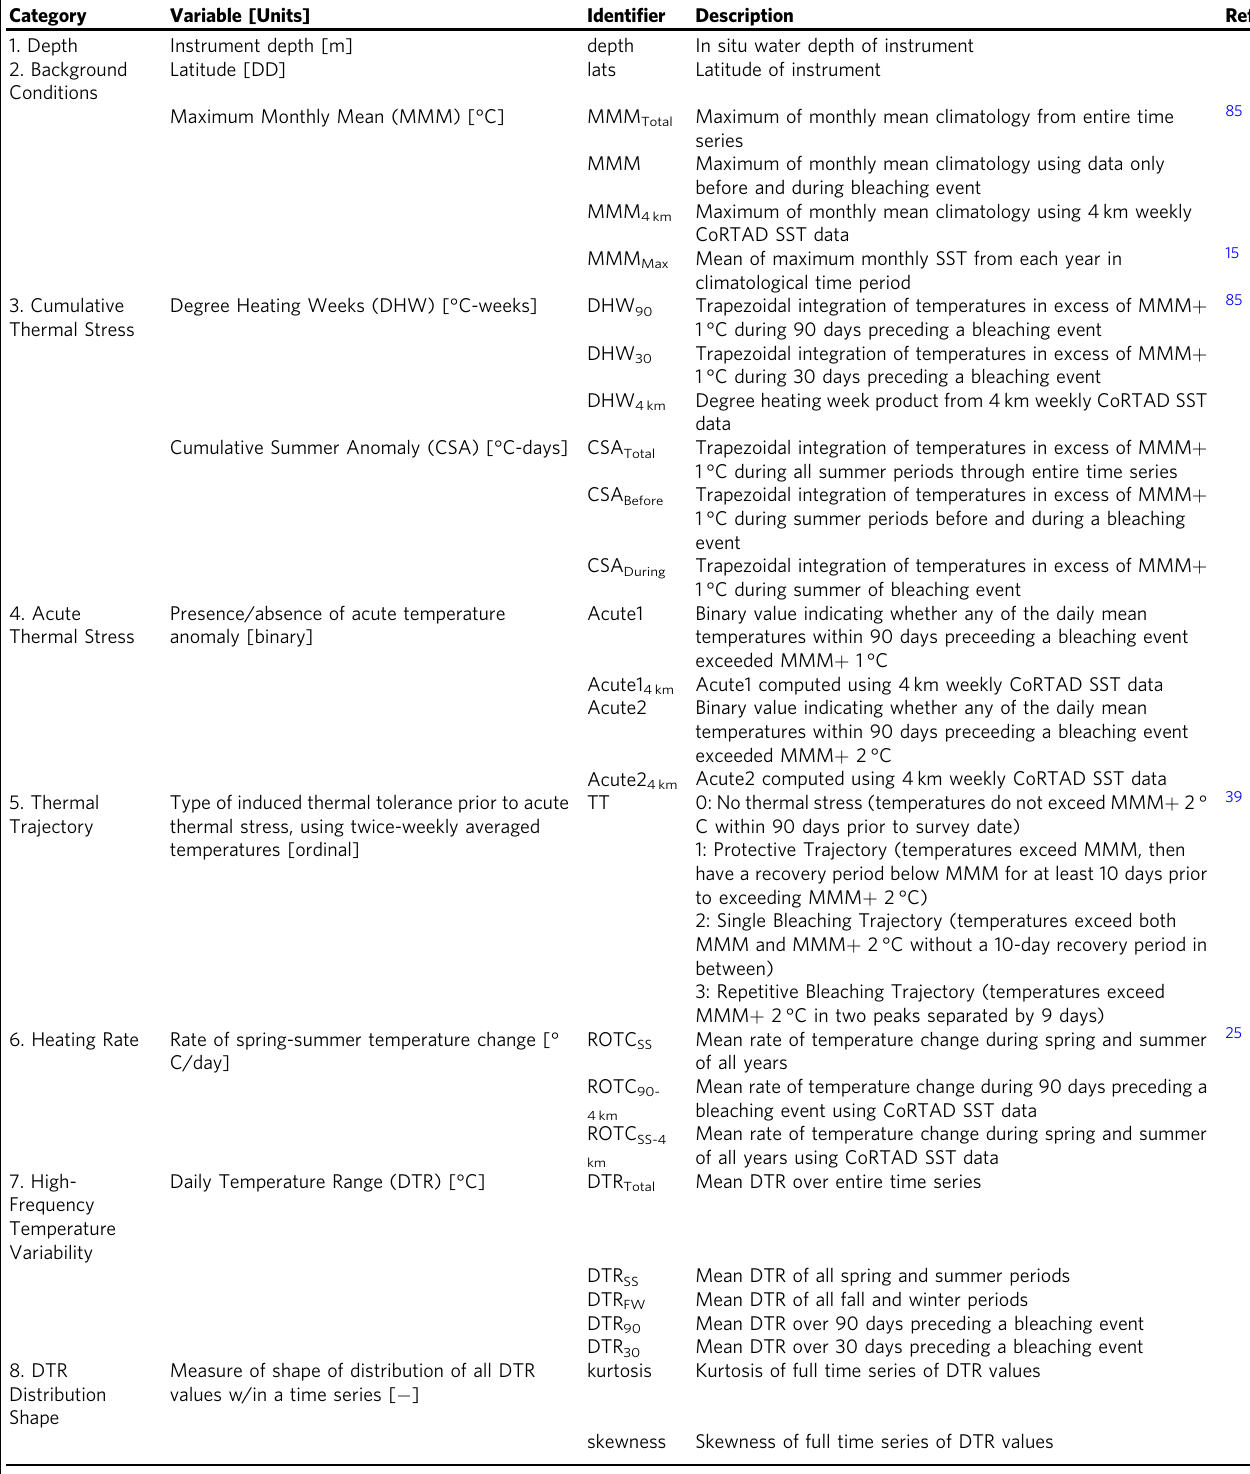
Variables are grouped according to eight categories representing different aspects of ecologically relevant environmental and temperature factors. Seasons were de fi ned such that each season spanned three complete months, and austral and boreal summers were December through February and June through August,